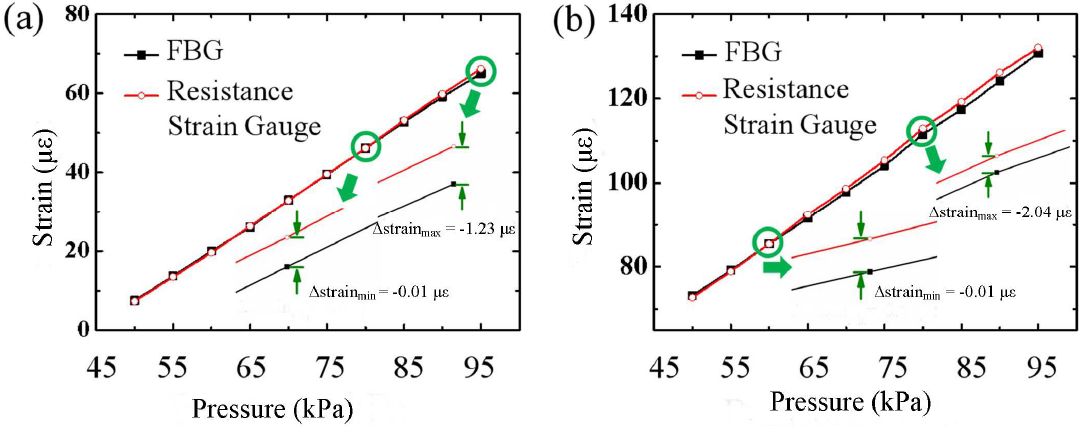
Figure 6. The comparison of the measurement results of the FBG after compensation and resistance strain gauge for Point A ( a ) and Point B ( b ).